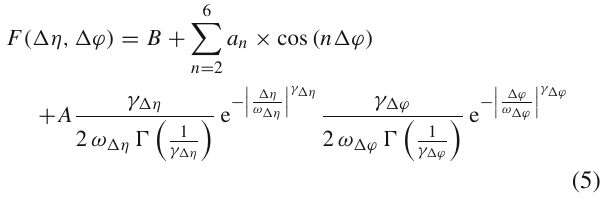
Fig. 2. widths and τ f ) used in All parameters (d N ch /d η , G CI 2 the computation of η/ s as well as the extracted values of η/ s at RHIC and LHC energies are listed in Table 1 as a function of collision centrality expressed in terms of the fractional cross section: the range 0–5% corresponds to most central collisions while ranges 5–10%, 10–20%, etc, represent collisions with increasingly larger impact parameters. Our analysis, based on STAR and ALICE is limited to quasi-peripheral collisions up to the range 70– 80%, beyond which the applicability of Gavin’s model might be put into question. Estimates of η/ s computed with Eq. 1 based on the above widths and freeze-out times are listed, for both RHIC and LHC energies, in the two right-most columns of Table 1 . The values of η/ s vs (d N ch /d η) 1 / 3 are plotted in Fig. 3. Statistical and system- atic uncertainties, the last ones incorporating the uncer- tainties from the fit procedure for freeze-out times extrac- tion, are displayed with vertical bars and rectangular boxes,